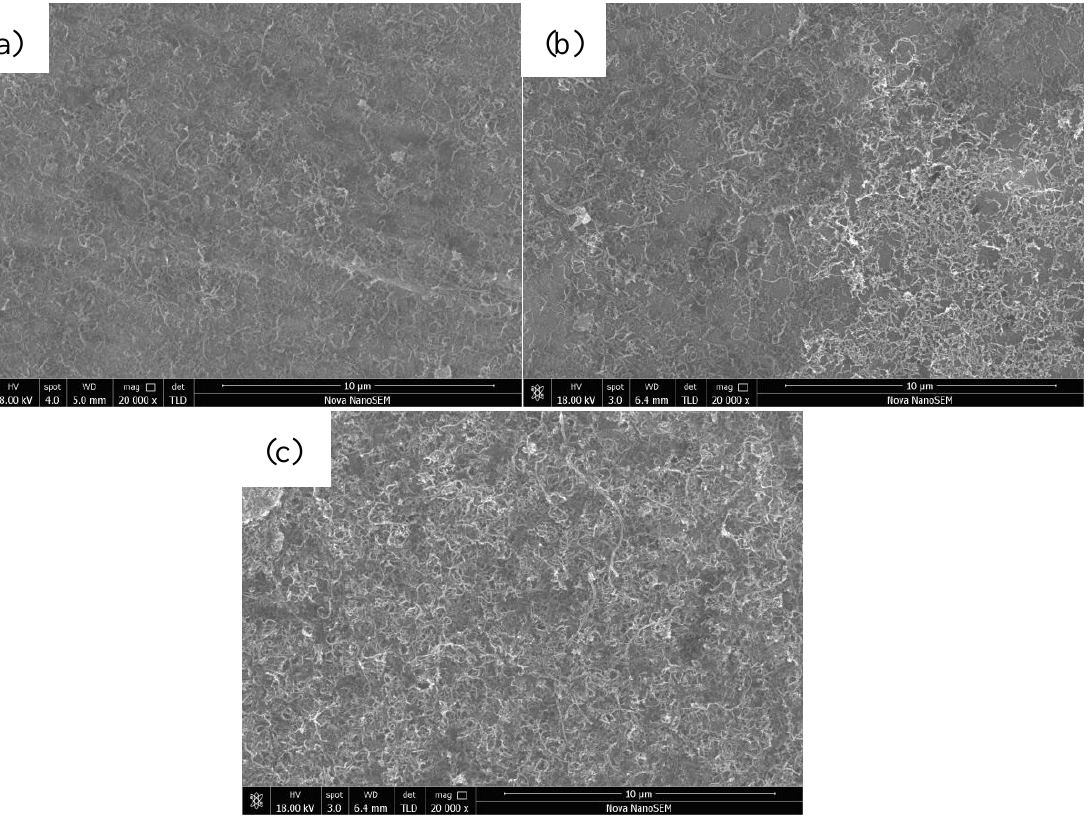
Figure 4. The SEM images for CNTs deposited on Mg foils with different EPD times: ( a ) 0.5; ( b ) 1; ( c ) 1.5 min.